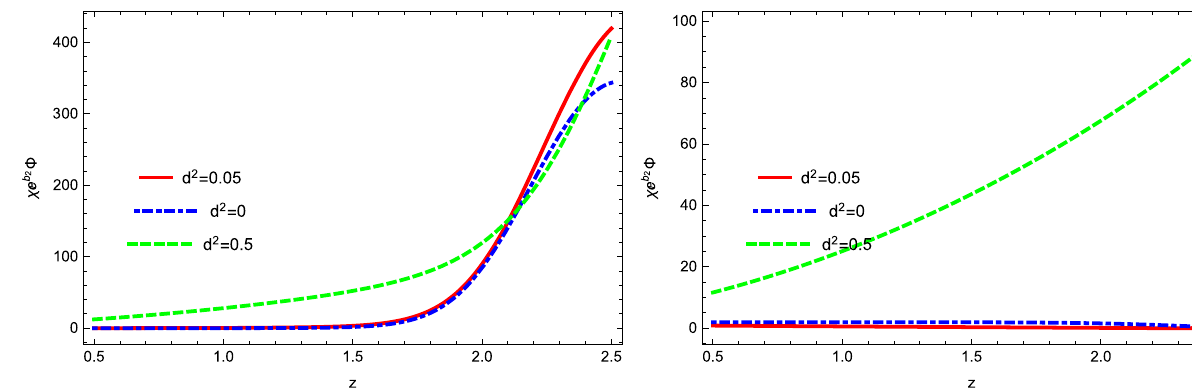
Fig. 43 Plot of χ e b 2 φ verses z for u = 1 and u = 2 . 002 for dilaton scalar field model